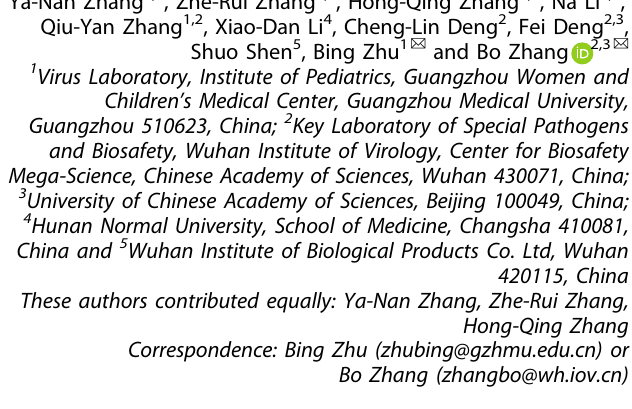
Fig. 1 The pathogenesis of SARS-CoV-2 Omicron variant in WT laboratory mice and golden (Syrian) hamsters. a Immuno fl uorescence assay in BHK-21 cells expressing mACE2 or hACE2 infected with SARS-CoV-2 Omicron variant. BHK-21 cells were transfected with mACE2 or hACE2 expression plasmid. After 24 h post-transfection, the cells were infected with SARS-CoV-2 WT or Omicron variant at an MOI of 0.01. Cells were fi xed at 24 hpi and stained for IFA assay to detect the expression of S-tag and viral NP proteins. b Flow chart of both young (8-week-old) and old (9-month-old) BALB/c mice ( n = 3) infected with SARS-CoV-2 Omicron variant. All the BALB/c mice were intranasally infected with 2 × 10 4 PFU Omicron variant in a total volume of 50 μ L. c – f Characterization of SARS-CoV-2 Omicron variant infection in 8-week-old BALB/c mice. c Viral RNA loads and (d) virus titers of lungs and nasal turbinates were determined by qRT-PCR and plaque assays, respectively. e Body weight was monitored daily after the infection. f Pathological changes in the lungs of infected young BALB/c mice. g – j Characterization of SARS-CoV- 2 Omicron variant infection in 9-month-old BALB/c mice. g Viral RNA loads and h viral titers were determined as above described. i Body weight was monitored daily after the infection. j Pathological changes in the lungs of infected old BALB/c mice. k Flow chart of SARS-CoV-2 Omicron variant infection in golden (Syrian) hamsters. The hamsters ( n = 3) were intranasally infected with 2 × 10 4 PFU Omicron variant in a total volume of 100 μ L. l – o Characterization of SARS-CoV-2 Omicron variant infection in golden (Syrian) hamsters. l Viral RNA loads and m viral titers of lungs and nasal turbinates were determined by qRT-PCR and plaque assays, respectively. n Body weight was monitored daily after the infection. o Pathological changes in the lungs of infected hamsters. Obvious gross pathology changes in the lungs were depicted by blue arrows. Two-way ANOVA was used to determine statistical differences between groups. * p < 0.05, ** p < 0.01, ns represents not signi fi